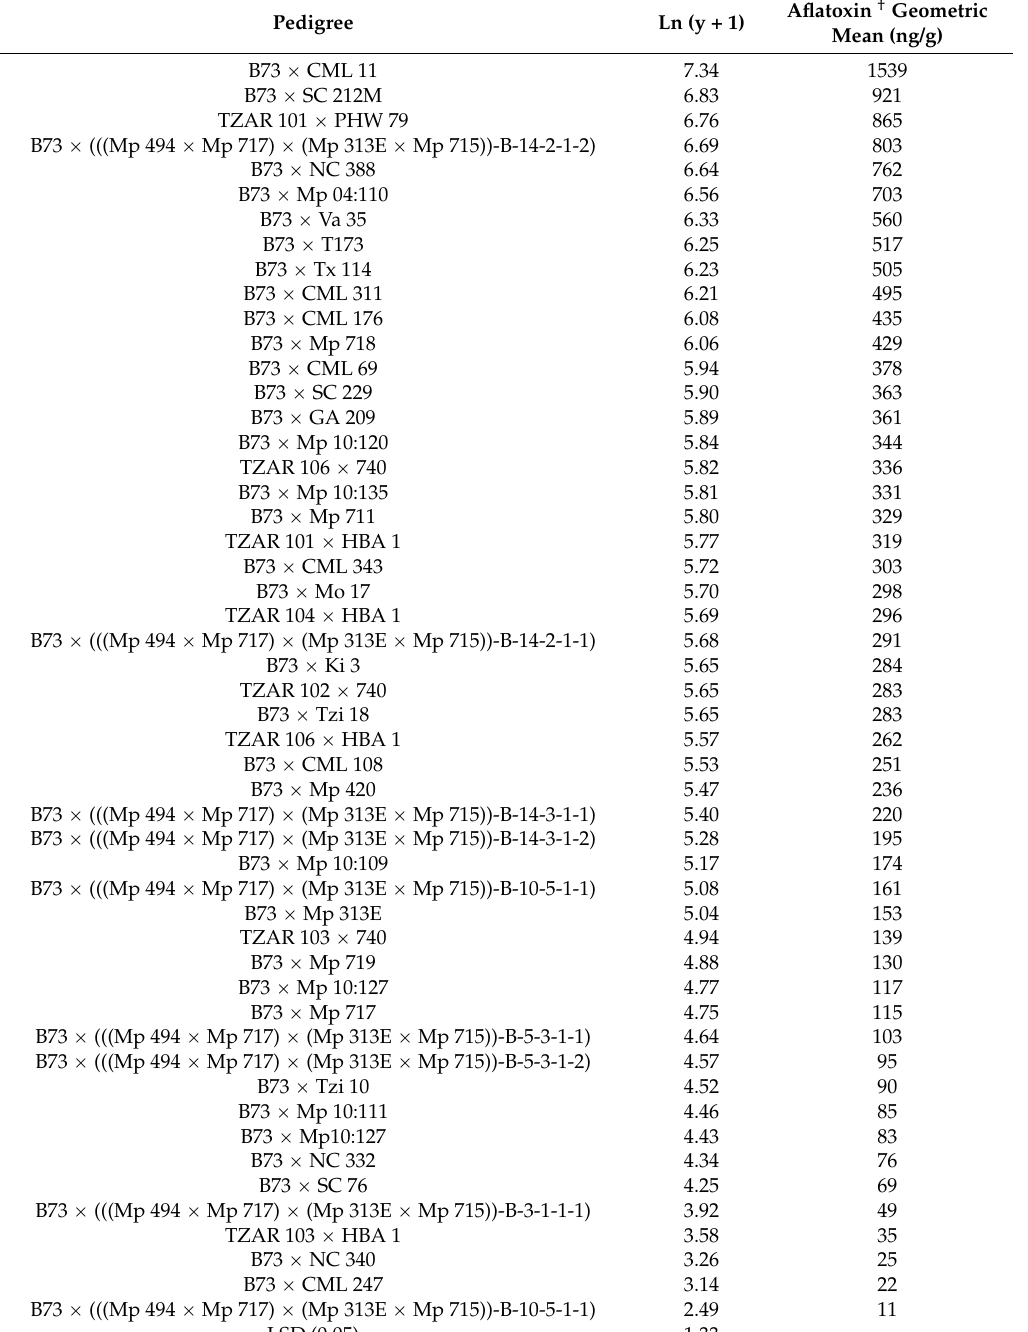
Table 2. Aflatoxin accumulation in single-cross hybrids evaluated at Mississippi State in